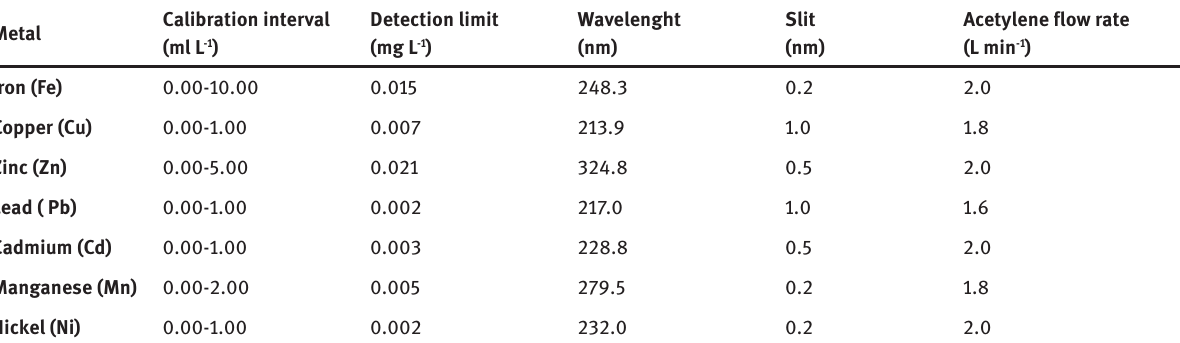
Table 1: Working conditions of AAS